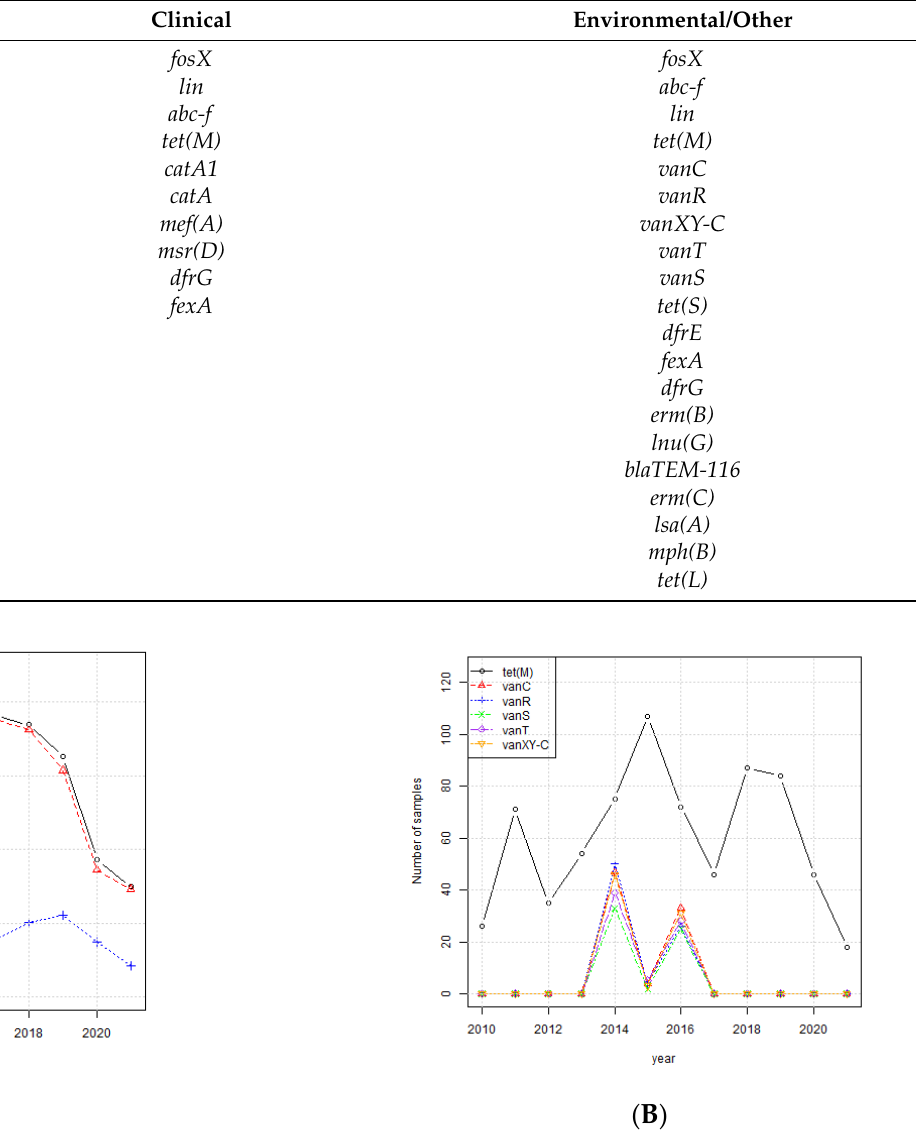
Table 4. Highly occurring AMR genes by isolation type.